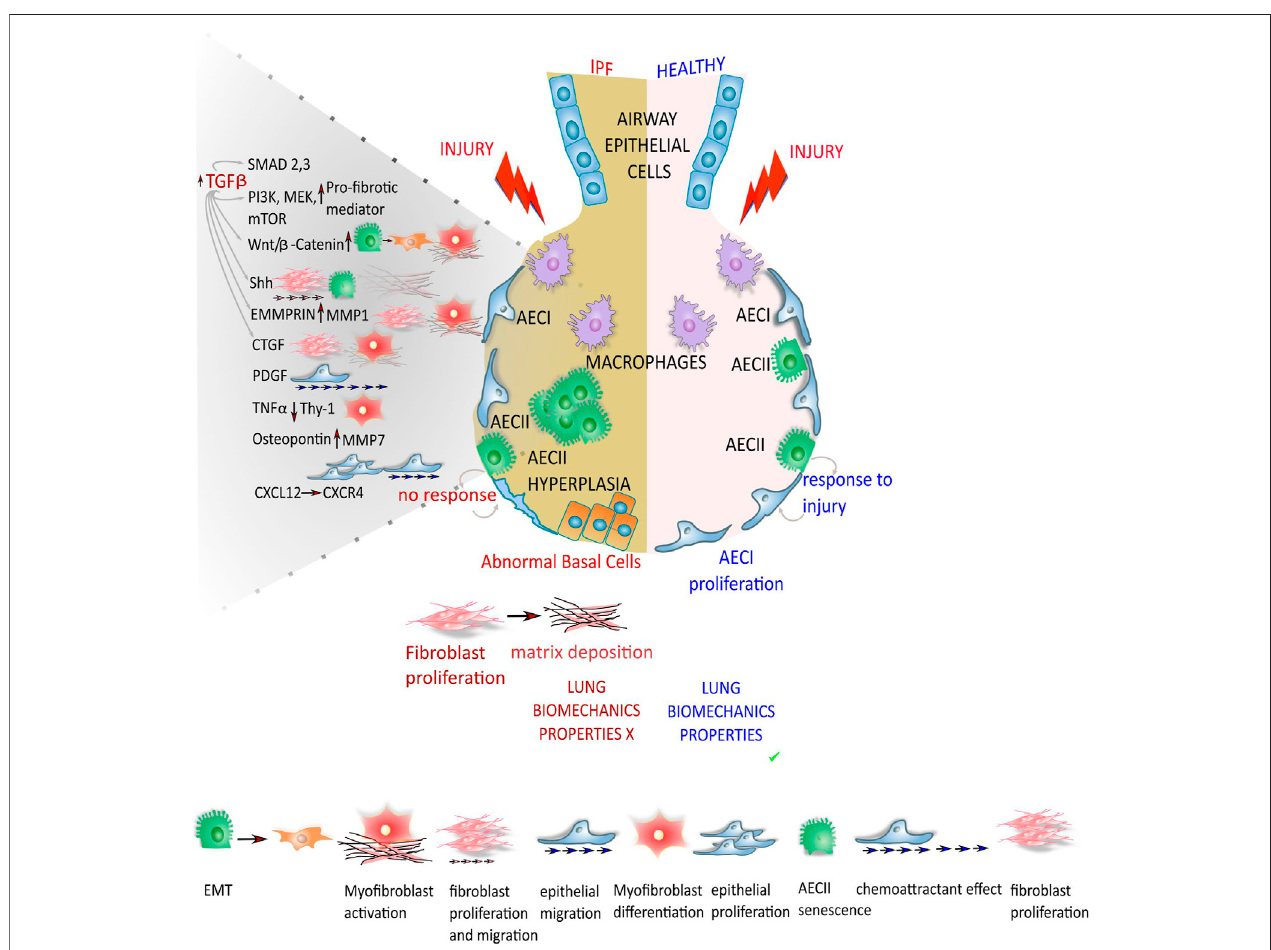
FIGURE 1 | Different response from the epithelium to lung injury in normal and IPF lung. In normal lung, the depletion of alveolar epithelial cells 1 (AECI) that play a pivotal role in gas exchange with the adjacent blood vessels after injuries, is compensated/replenished by/upon the differentiation of alveolar epithelial cells 2 (AECII) in AECI, restoring the alveolar epithelium. In lung epithelium of IPF patients, the regeneration of AECI by AECII progenitors is compromised, leading to impaired alveolar re- epithelialization.TogetherwiththeaberrantrepairmechanismstheAECsstarttosecretepro- fi broticmediatorsthatthroughdifferentmolecularpathwayanddown- stream effectors lead to fi broblast migration, proliferation, activation and differentiation into myo fi broblasts with deposition of exaggerated ECM that drastically compromise the lung biomechanics properties.